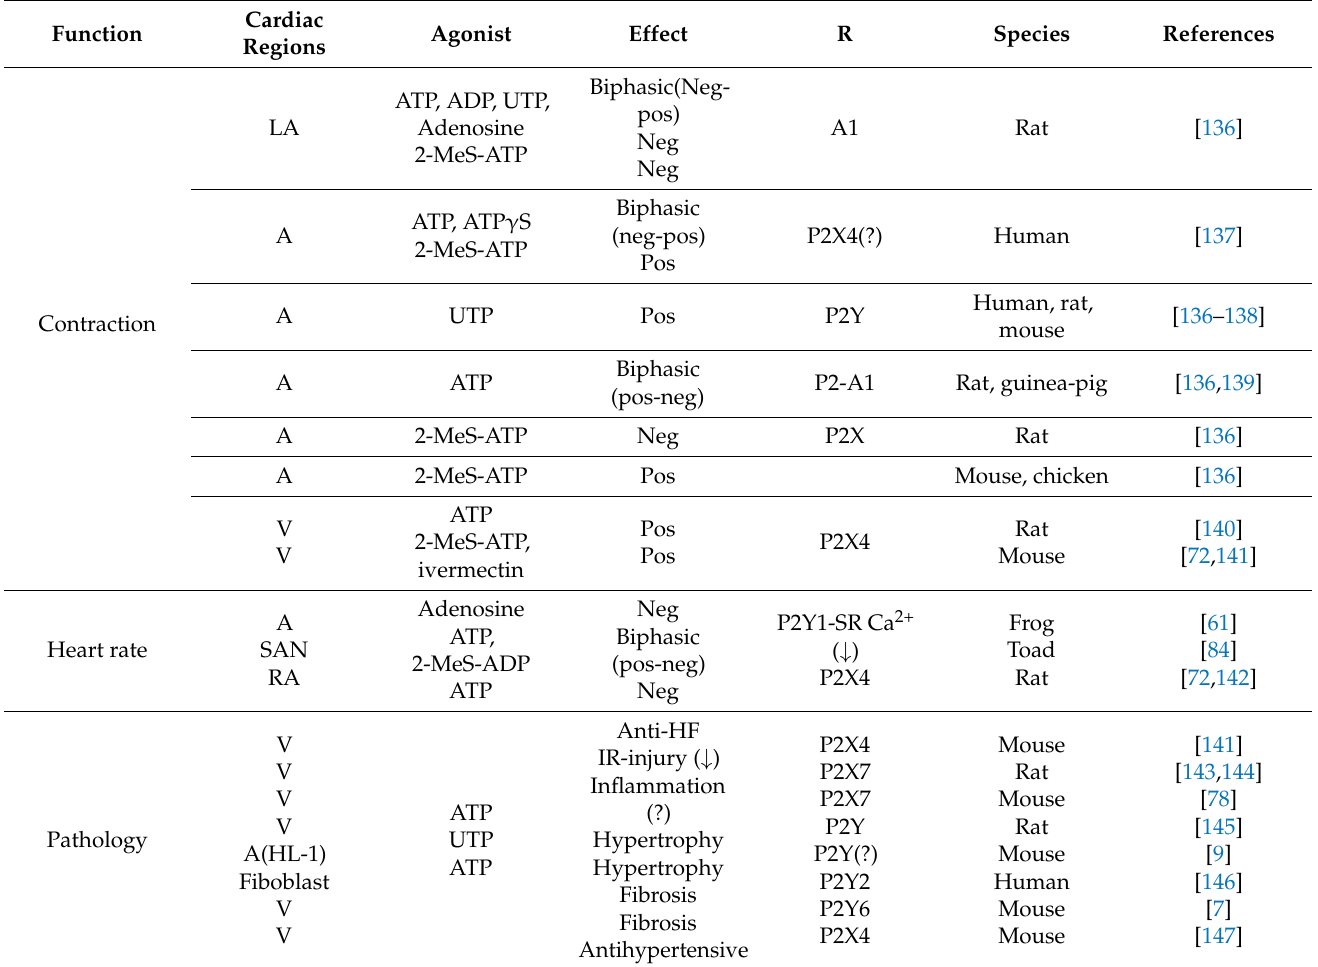
Table 2. Pathophysiological functions of P2 receptor subtypes in cardiac